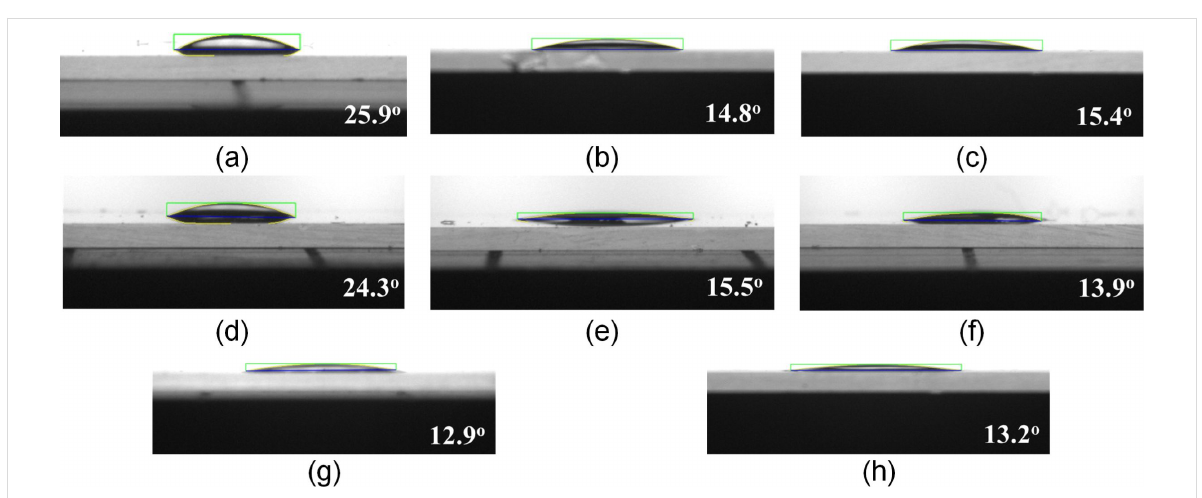
Figure 2: Contact angles of the coating films fabricated using various annealing treatment methods: (a) naturally dried; (b) annealed with RTA; (c) annealed with a furnace; (d) annealed once with a gas torch; (e) annealed two times with a gas torch; (f) annealed three times with a gas torch; (g) annealed four times a with gas torch; and (h) annealed five times with a gas torch.